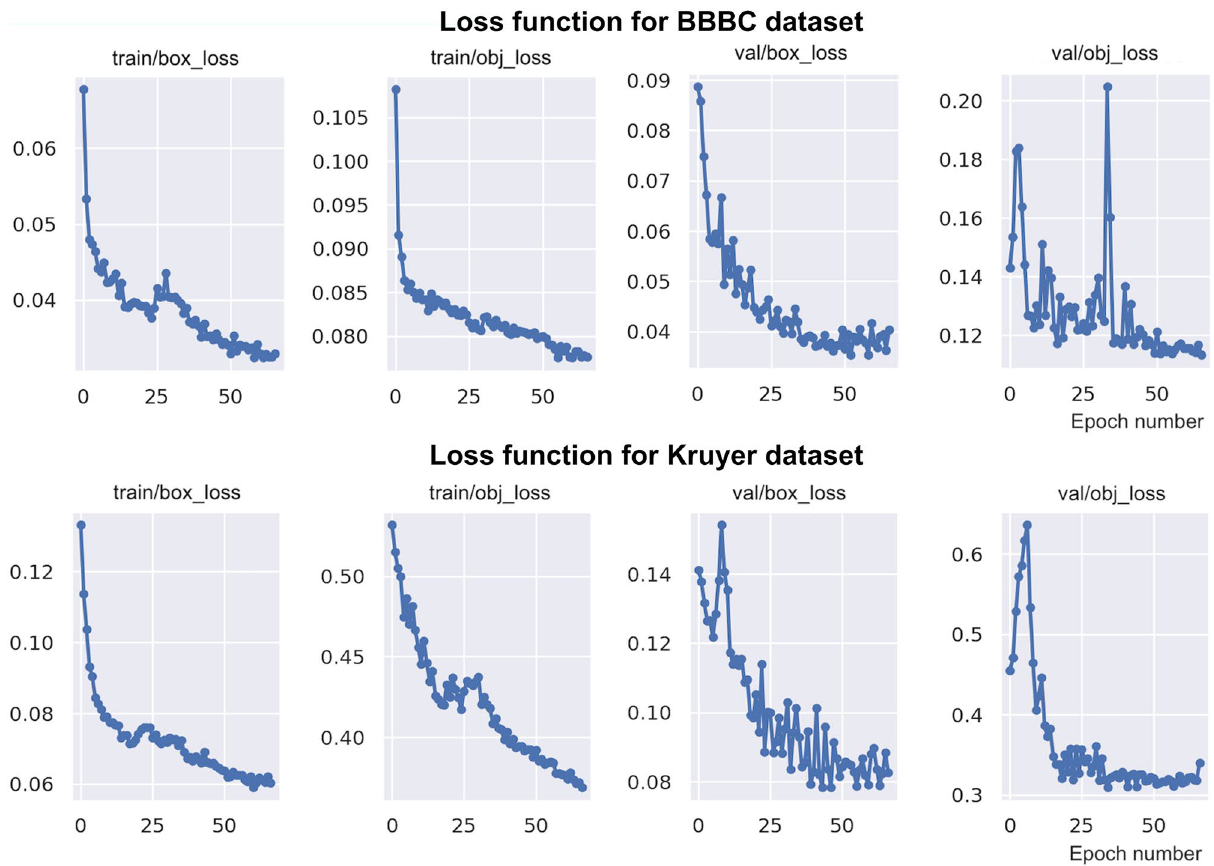
Figure 2. Loss function. Plots display location or bounding box losses (box_loss) and objectness losses (obj_loss) as a function of the number of epochs during training and validation for the BBBC (top) and Kruyer (bottom)